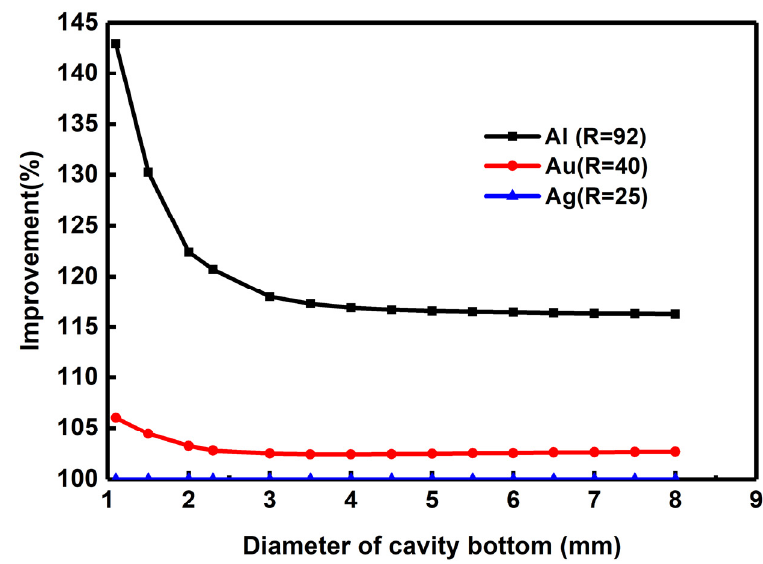
Figure 6. Simulated improvements in the LEE performance levels of DUV-LEDs with Al reflector cavities relative to those of DUV-LEDs with Ag and Au cavities.